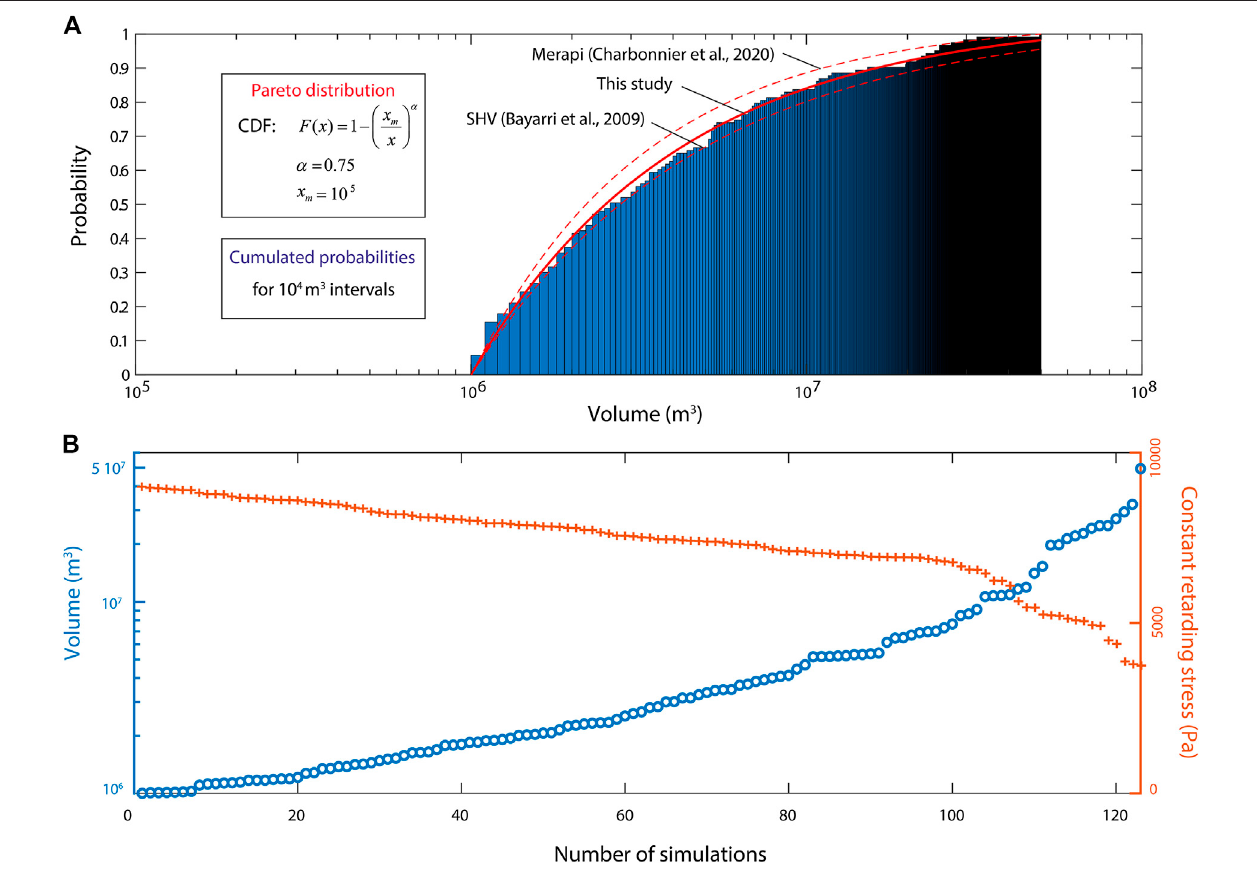
FIGURE 7 | Distribution of the 123 simulated pyroclastic current volumes sampled using a Pareto law. Graph (A) shows the cumulative probabilities of the pyroclastic current volumes (bars), obtained following the Pareto distribution for the volume range 1 × 10 6 to 50 × 10 6 m 3 . The selected Pareto law with a shape parameter α (cid:2) 0.75isrepresentedbythesolidredlineandencircledbytheParetolawsfromBayarrietal.(2009)andCharbonnieretal.(inpress)asdashedredlines,with a shape parameter α (cid:2) 0.64 and α (cid:2) 0.83, respectively. Graph (B) shows the distribution of the 123 volumes together with their associated constant retarding stress.